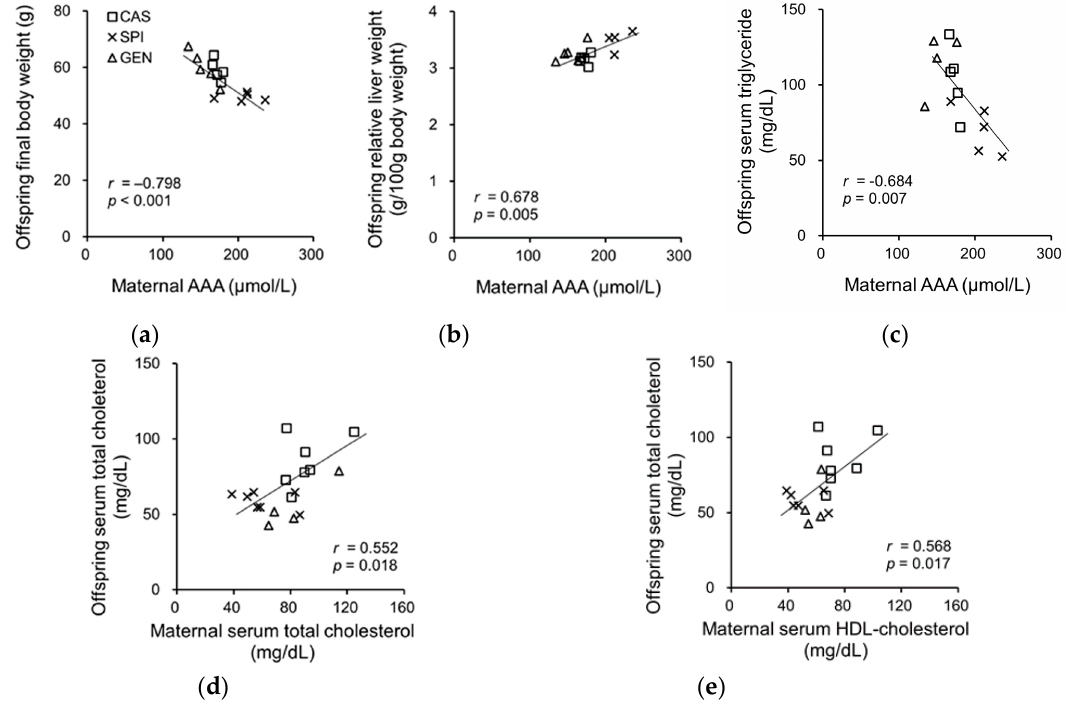
Figure 5. Correlation between ( a ) serum AAA levels in dams and body weight; ( b ) serum AAA levels in dams and relative liver weight of offspring; ( c ) serum AAA levels in dams and serum triglyceride levels in offspring; ( d ) serum total cholesterol levels in dams and serum total cholesterol levels in offspring; ( e ) serum high-density lipoprotein (HDL) cholesterol levels in dams and serum total cholesterol levels in offspring AAA, aromatic amino acid. Pearson correlation coefficient, r and p -value are indicated.